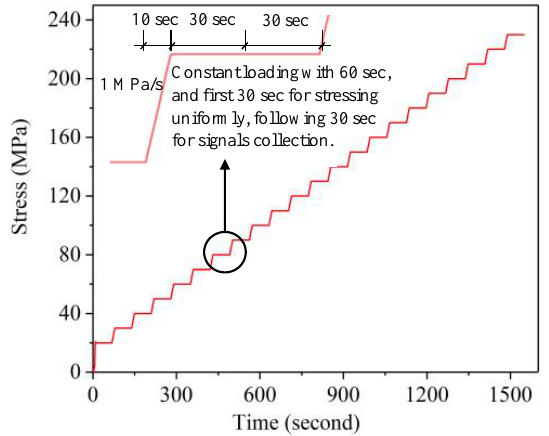
Figure 5. The increasing step load history applied on the three specimens.